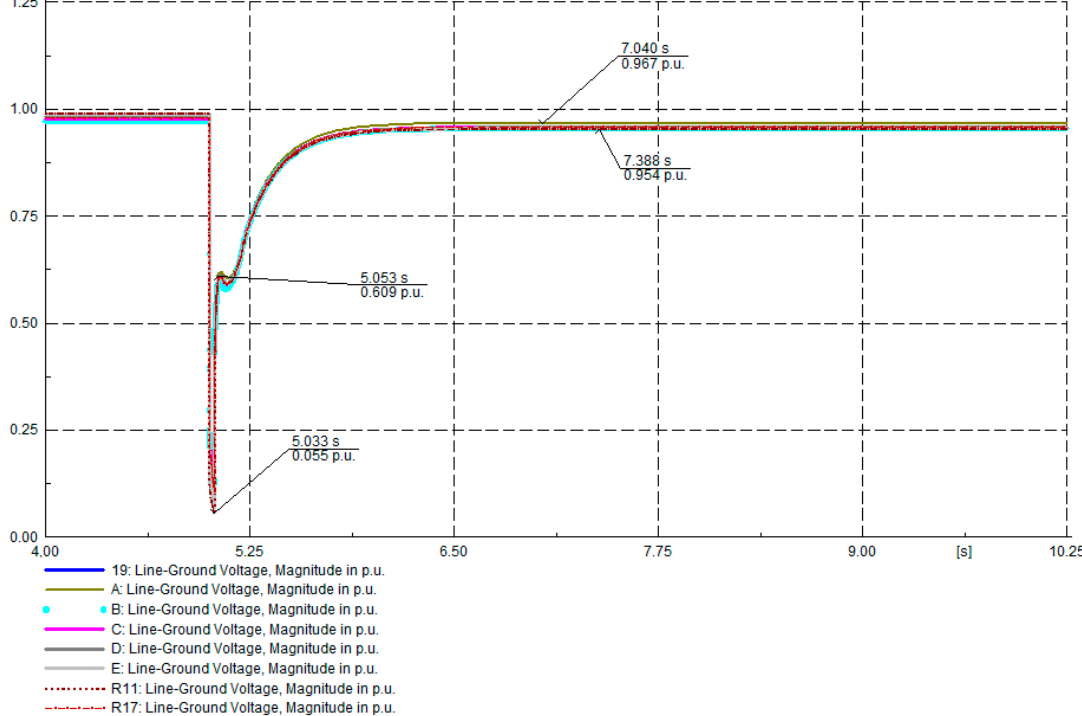
Figure 7. The voltage on bus R19, RA, RB, RC, RD, RE, and bus R11 in grid connected and islanded modes .